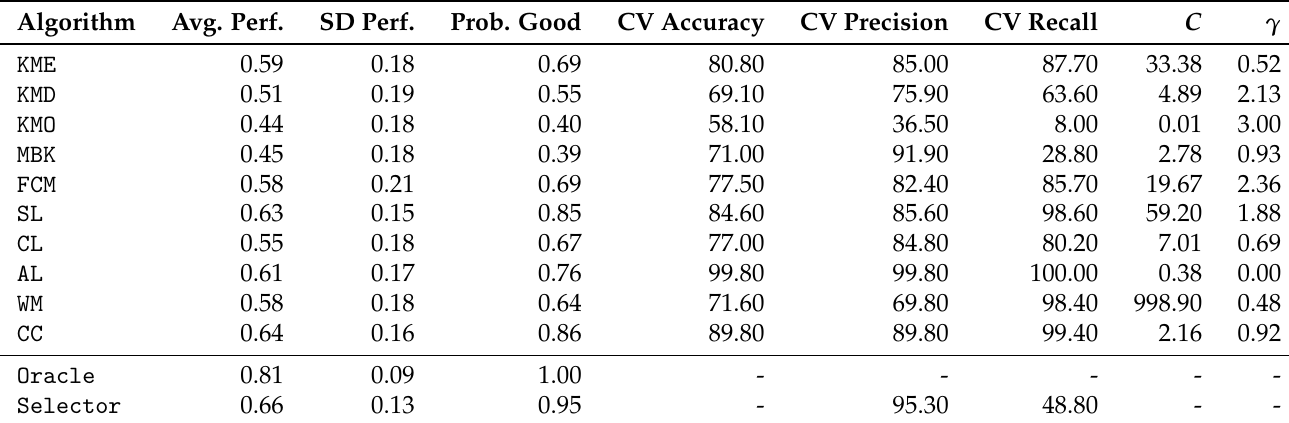
Table 6. Results of SVM prediction models after inclusion of real datasets, where Avg. Perf. is the Average Performance, SD Perf. is the Standard Deviation Performance, CV Accuracy, CV Precision and CV Recall are cross-validated performance metrics, C is the cost in the regularization term and γ is the RBF hyper-parameter.